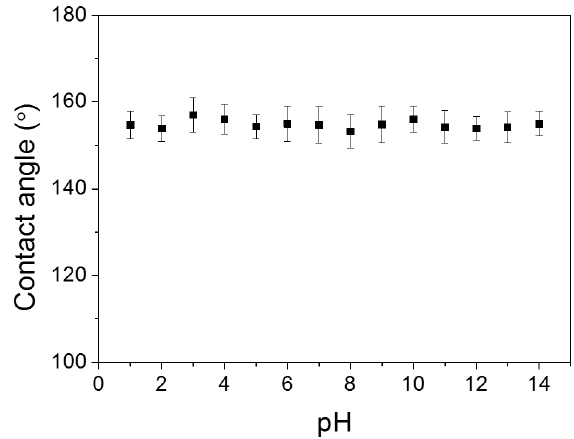
Figure 6: pH resistance of the superhydrophobic PP surface scraped with P360 abrasive paper and then bonded and peeled.